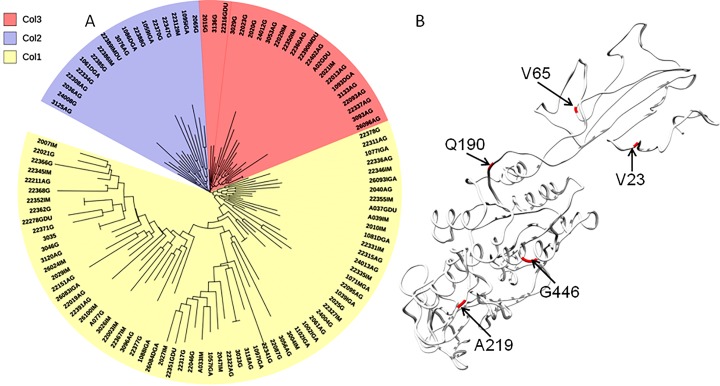
Phylogenetic tree of AlpA proteins from Colombian isolates of Helicobacter pylori.(A) The evolutionary history was inferred using the Neighbor-Joining method. The optimal tree with the sum of branch length = 0.84663616 is shown. The percentage of replicate trees in which the associated taxa clustered together in the bootstrap test (1,000 replicates); significant consensus tree branches are showed. The evolutionary distances were computed using the JTT matrix-based method and are in the units of the number of amino acid substitutions per site. The rate variation among sites was modeled with a gamma distribution (shape parameter = 2). The analysis involved 108 amino acid sequences. All positions containing gaps and missing data were eliminated. There were a total of 451 positions in the final dataset. Three major clades were detected: (1) Col1; (2) Col2 and (3) Col3. (B) Comparison all-vs-all between Colombian phylogenetic tree clusters reveals that Col1/Col3 clades have five sites with a θD > 0.8 indicating a strong signal of functional divergence.